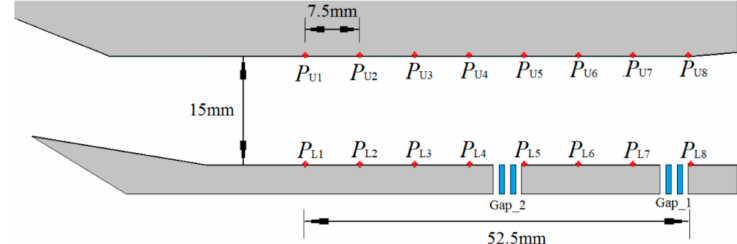
Figure 2. Schematic of sampling